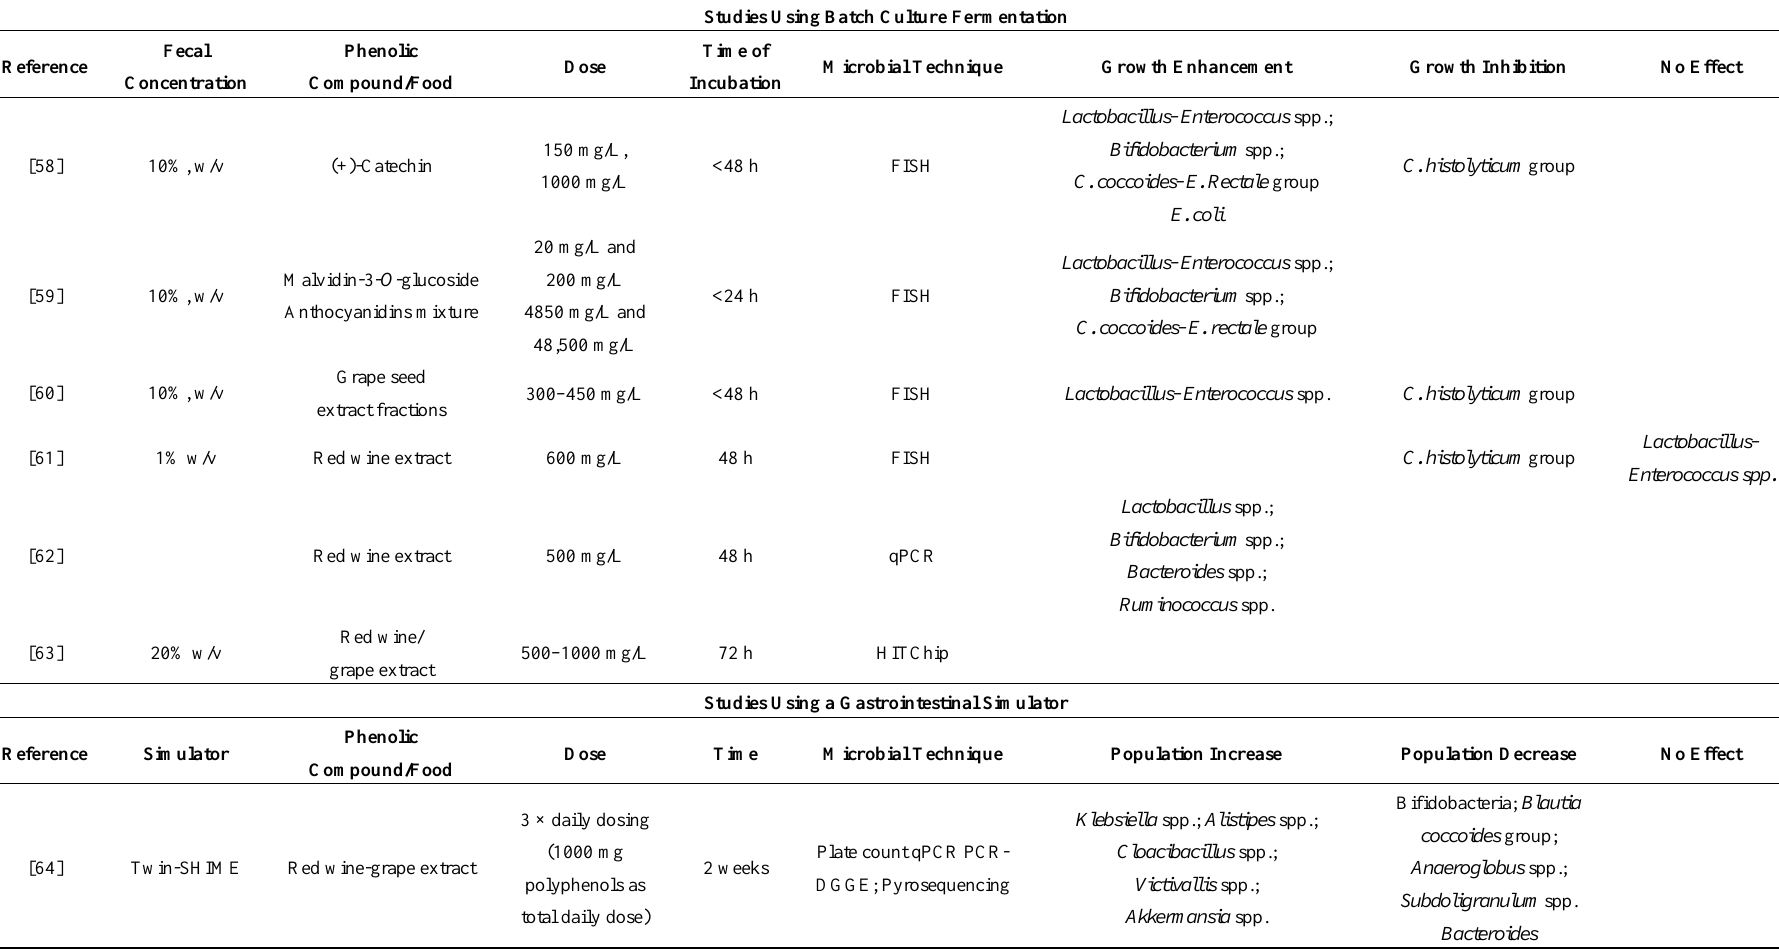
Table 1. Studies regarding modulation of gut microbiota by wine polyphenols using batch culture fermentations and gastrointestinal tract